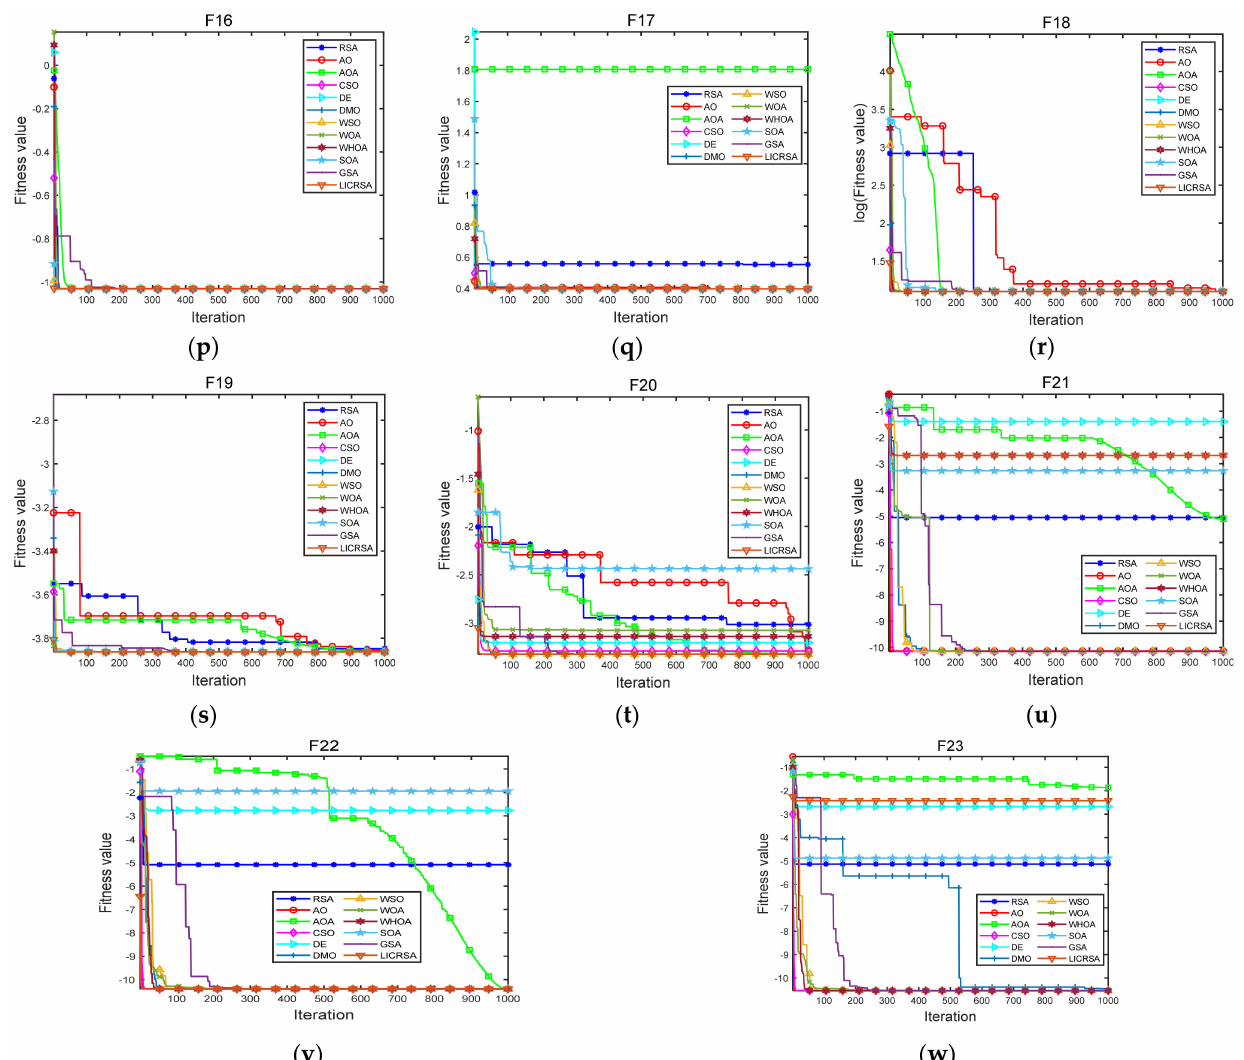
Figure 7. Convergence curves of LICRSA and different MH algorithms: ( a ) F01; ( b ) F02; ( c ) F03;